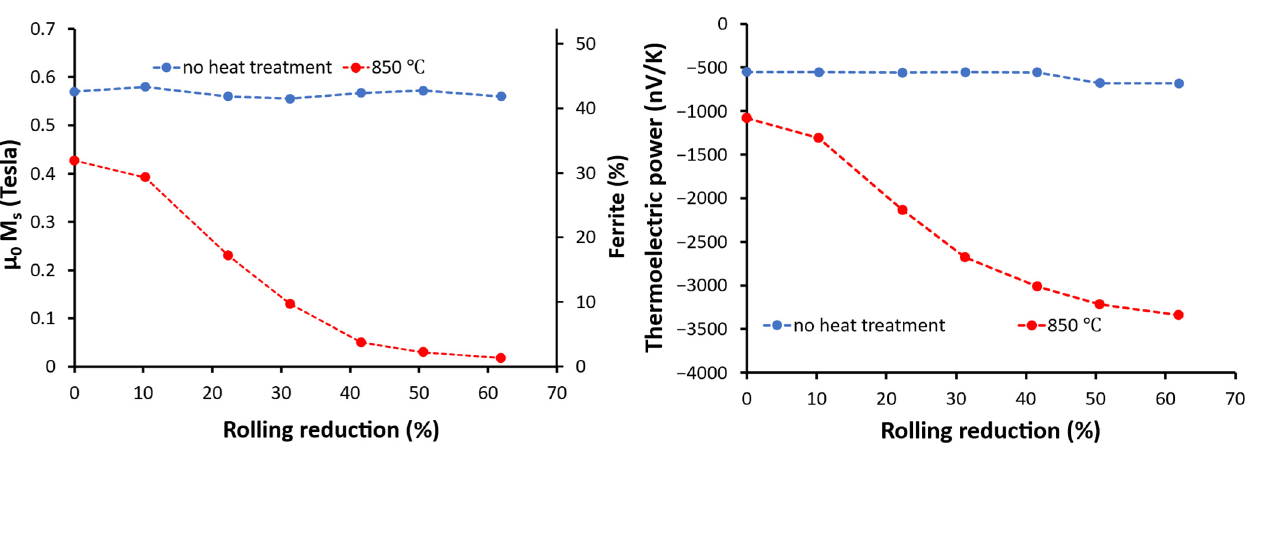
Figure 5. ( a ) Magnetic saturation polarization vs. rolling reduction; ( b ) Thermoelectric power vs. rolling reduction of the cold-rolled (blue) and cold-rolled + heat-treated (red) samples.